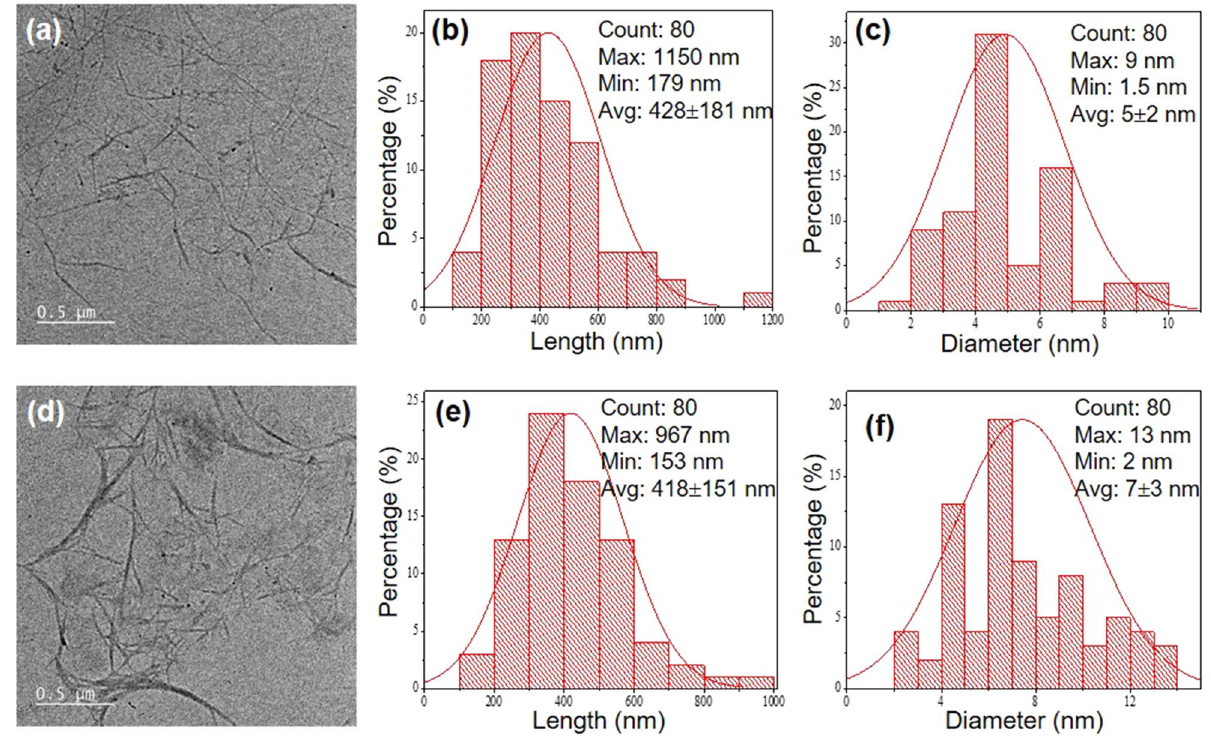
Figure 2. TEM images and size distributions of ( a , b , and c ) CNCs and ( d , e , and f )